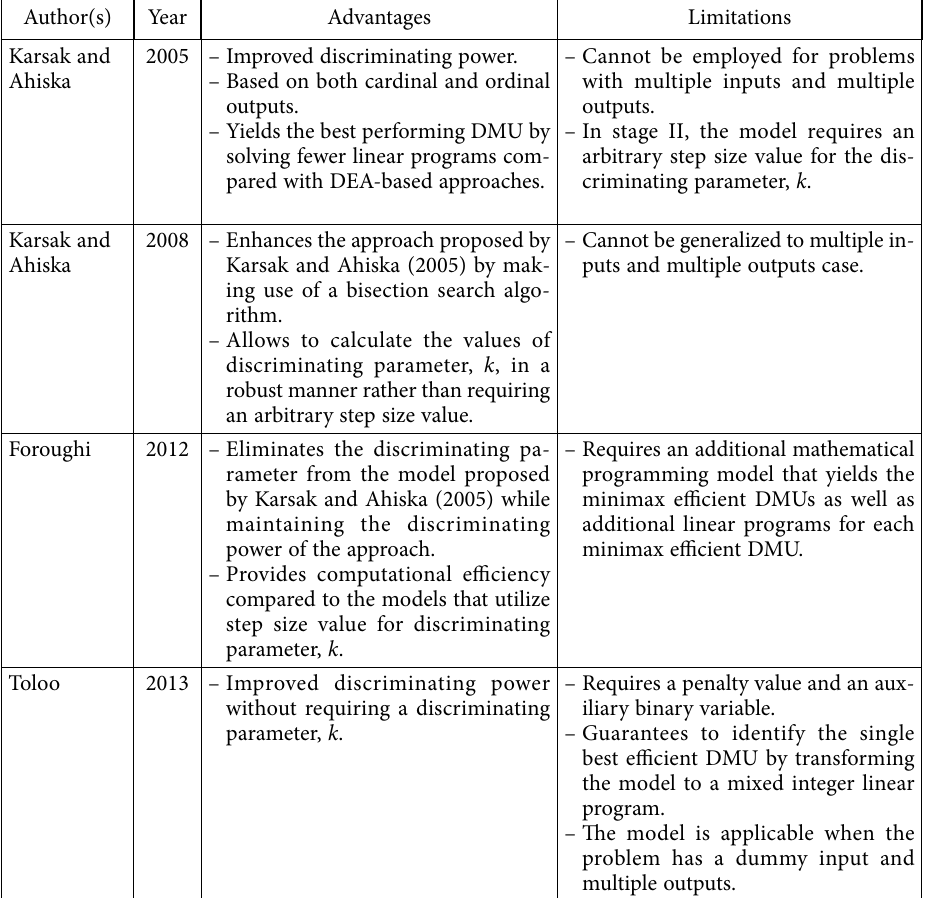
Table 1. Advantages and limitations of DEA-based models including single input and multiple